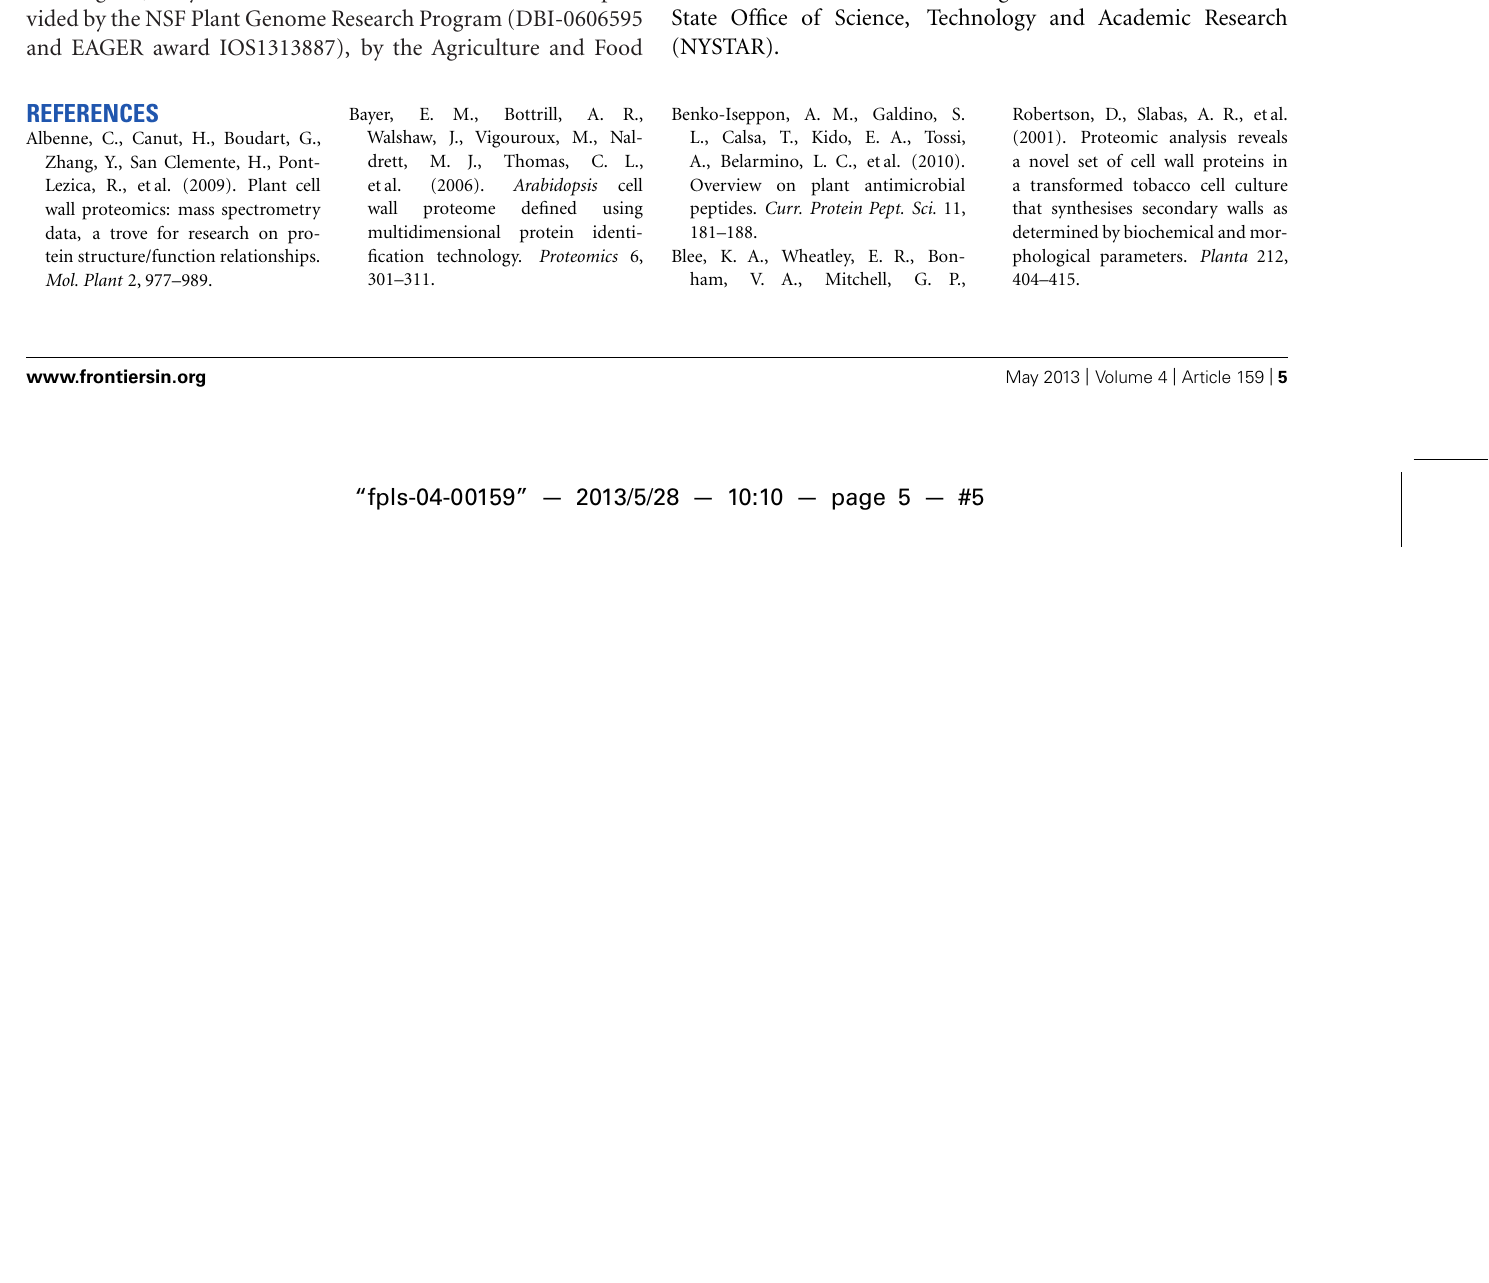
of proteins identified in RR stage in different cultivars of tomato. (C) Classification of proteins in enriched proteome studies targeting the cuticle [immature green (IG) stage] or after using lectin affinity chromatography (RR